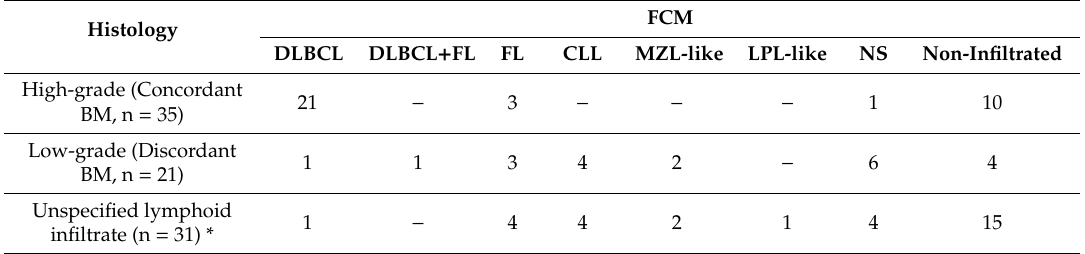
Table 2. Phenotypic characteristics of bone marrow (BM) lymphoid infiltrates according to histology.